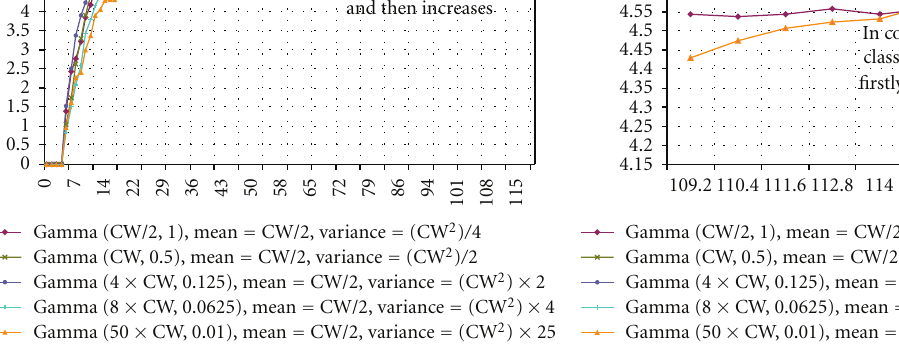
Figure 12: Transmission probabilities of voice and video classes for five di ff erent scenarios ( n = 24). With variance increment, Intra-class contention takes place of Inter-class contention. (right): τ i for video class increases and then decreases. (left): In contrast to video class, in voice class τ i firstly decreases and then increases.